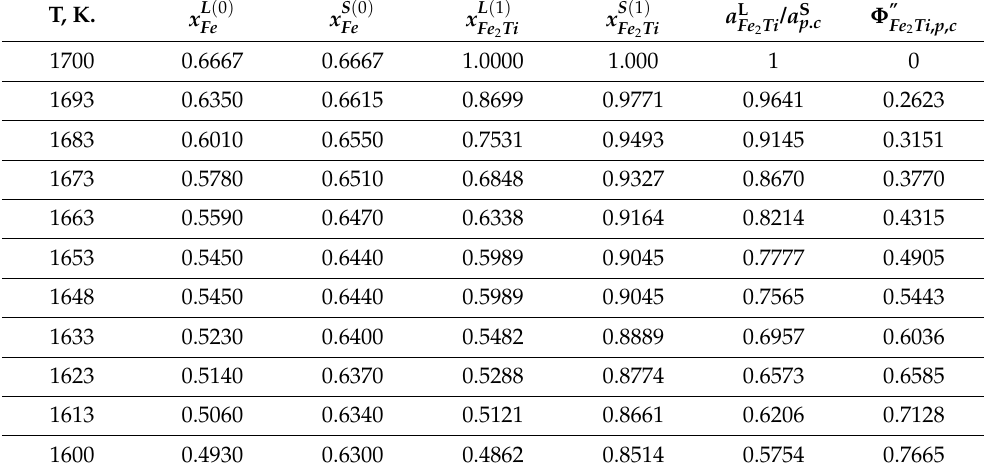
Table 3. The initial data of the Fe 2 Ti crystallization region for the particular Fe 2 Ti-Ti system. T,